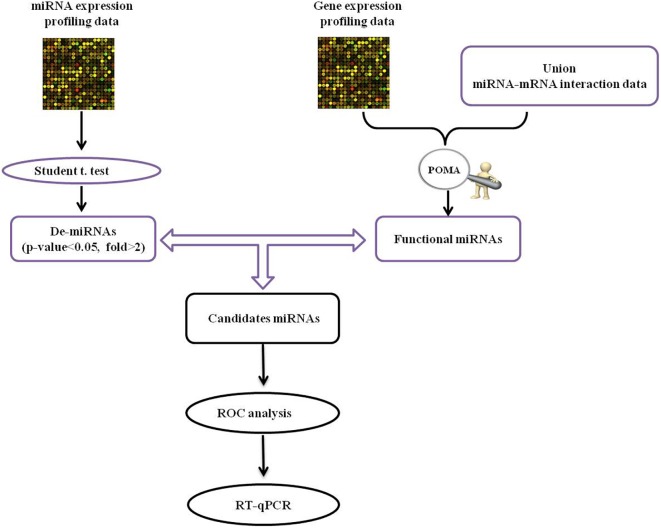
The schematic pipeline for PD miRNA biomarker identification. POMA, pipeline of outlier miRNA analysis; DE, differentially expressed; ROC, receiver operating characteristic curve; qRT-PCR, reverse transcription real-time quantitative PCR.